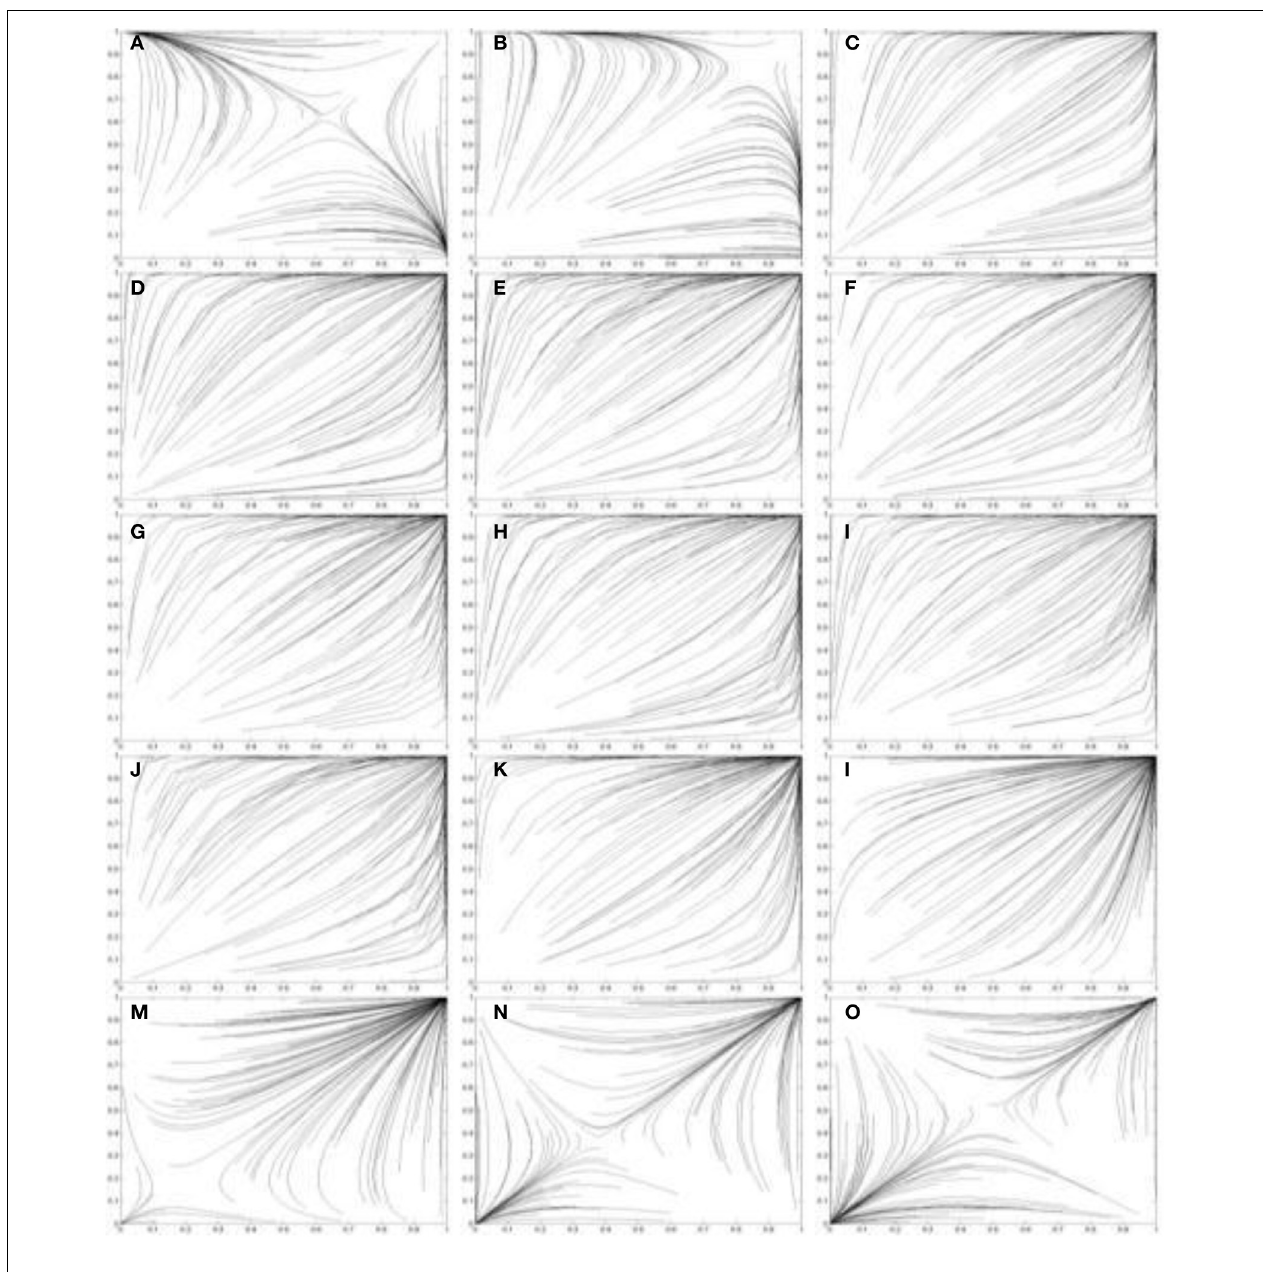
FIGURE 8 | Simulations of one hundred pairs of agents playing thirty iterations of the Chicken game. Agents share different values of I ∗ j in each simulation. (A) I ∗ j = 3 . 8; (B) I ∗ j = 3 . 6; (C) I ∗ j = 3 . 4; (D) I ∗ j = 3 . 2; (E) I ∗ j = 3 .